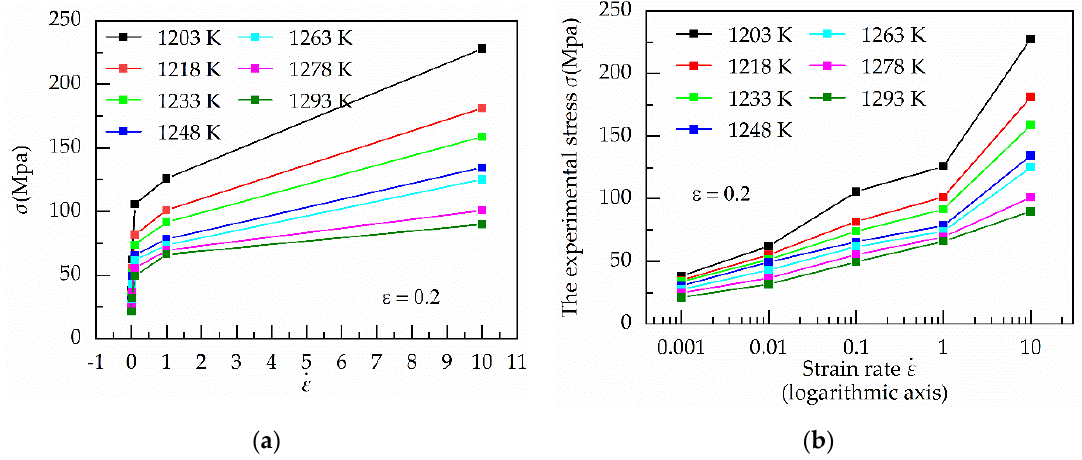
Figure 1. Relationship between ( a ) 𝜀 ̇ vs. the mean of σ ; ( b ) 𝜀 ̇ vs. σ under the strain of 0.20 and various deformation temperatures.